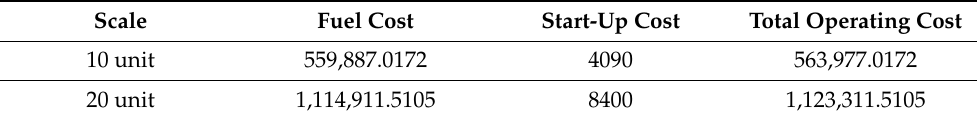
Figure 4. Performance of 10-generating units over 24 h (test system 1). Table 8. Fuel cost, start-up cost and total operating cost obtained by MPSO-EO (test system